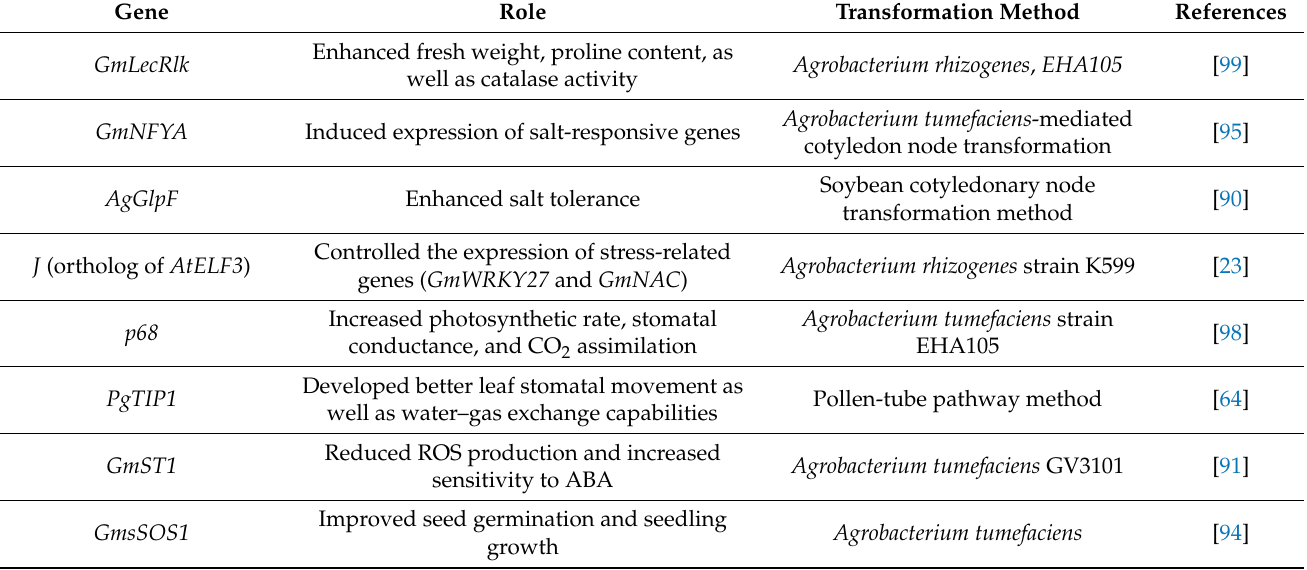
Table 5. Genetic engineering for salt tolerance in